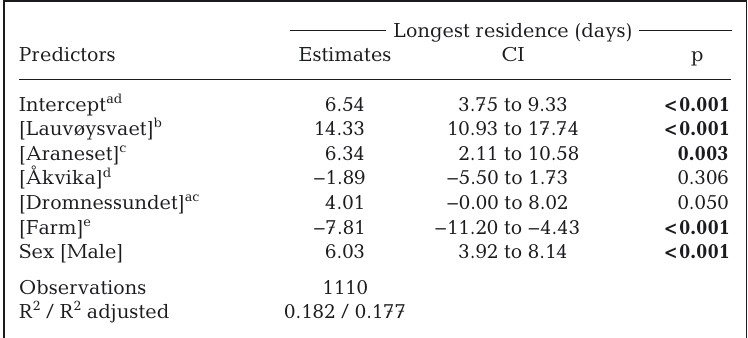
Table 4. Explanatory variables included in final models of cod residence time (Res Time). Given predictors are the effect of the categorical variables area and sex. Estimates is the parameter estimate of the predictor, CI is the 95% confidence interval and p is the p-value. Significance ( bold ) was assigned at p < 0.05. The treatment contrast of R was used with the intercept representing the value for females at Glasøysvaet and the value for the other areas and sex showing how they compare to this reference value. Square brackets indi- cate a categorical variable. The letters show the results of Tukey post hoc tests for the different areas, with different letters indicating significant differences. Only fixed effects are